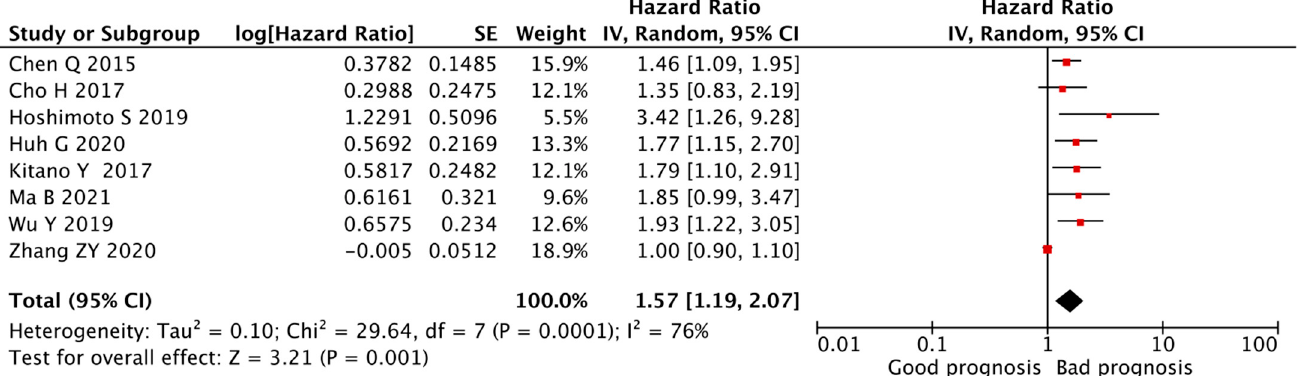
Figure 3. Forest plot of the correlation between PLR and DFS in CCA patients. A random-effects model was used to estimate the relationship between PLR and DFS. DFS, disease-free survival; PLR, platelet-to-lymphocyte ratio.